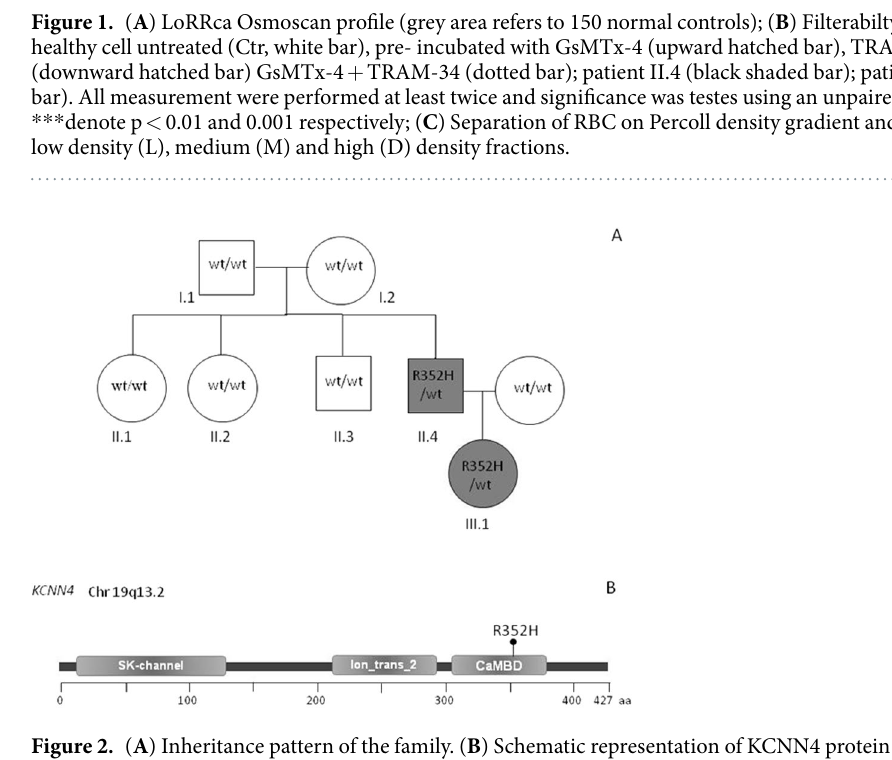
cost of ATP reduction (Fig. 5C), and stimulation of glycolysis in RBCs (could be observed as a facilitated deple- tion of plasma glucose and faster lactate production during 24 h of storage at room temperature (Glucose 2.45 vs. 3.20 mM and Lactate 8.25 vs. 5.6 mM in II.4 and control, respectively).